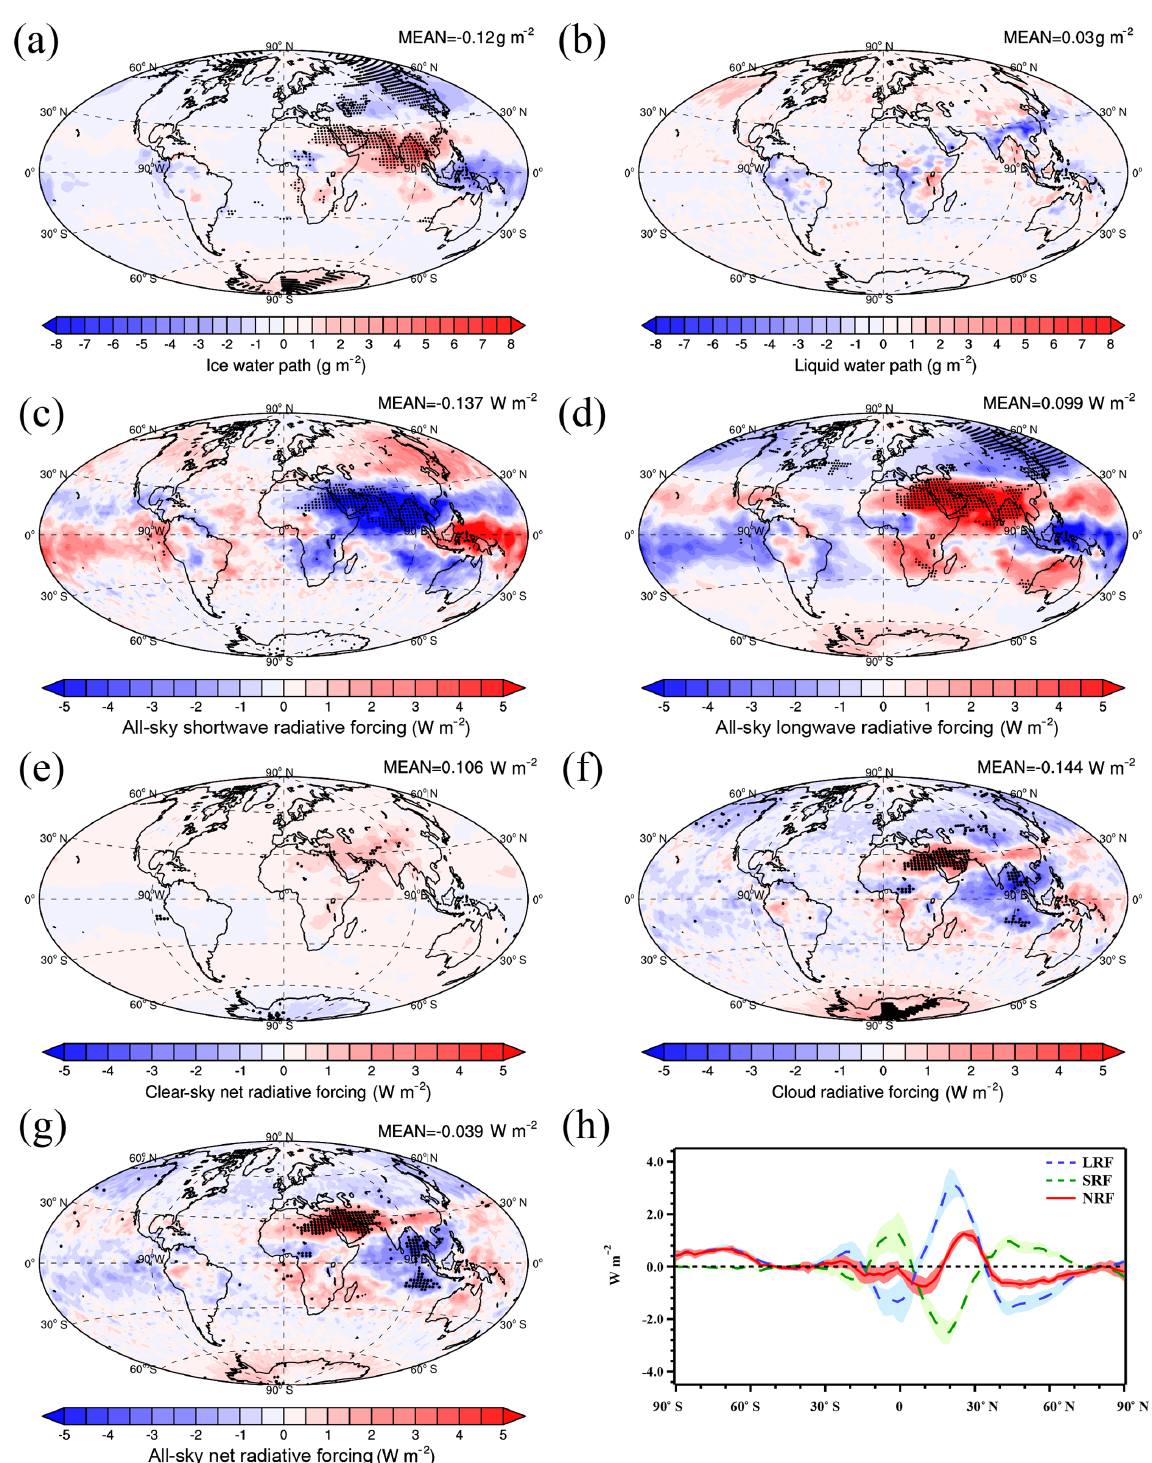
Figure 12. Annual mean plots of the changes in ice water path (a) , liquid water path (b) , all-sky shortwave radiative forcing (c) , all-sky longwave radiative forcing (d) , clear-sky net radiative forcing (e) , cloud radiative forcing (f) , and all-sky net radiative forcing (g) as well as longwave radiative forcing ( h , LRF, blue dashed line), shortwave radiative forcing ( h , SRF, green dashed line), and all-sky net radiative forcing ( h , NRF, red solid line) versus latitude for the difference between the PD_SOA and PI_SOA cases. Differences significant at the 90% level according to a Student’s t test are depicted by points. The shading in (h) represents 1 standard deviation of the interannual variation over 6